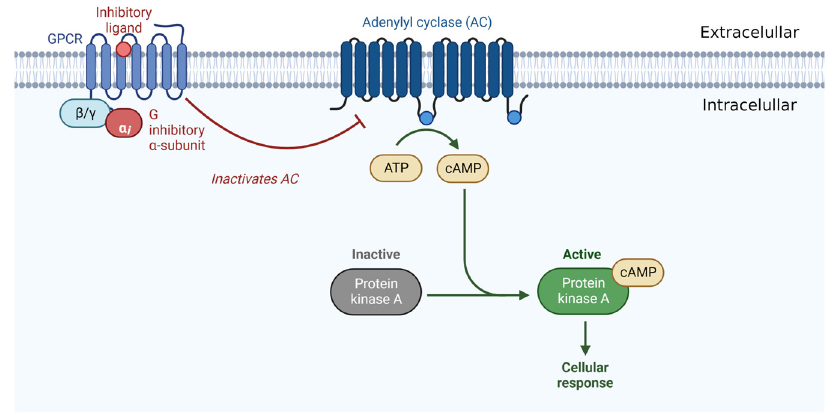
Figure 2. Illustration of a receptor belonging to the large family of GPCRs.